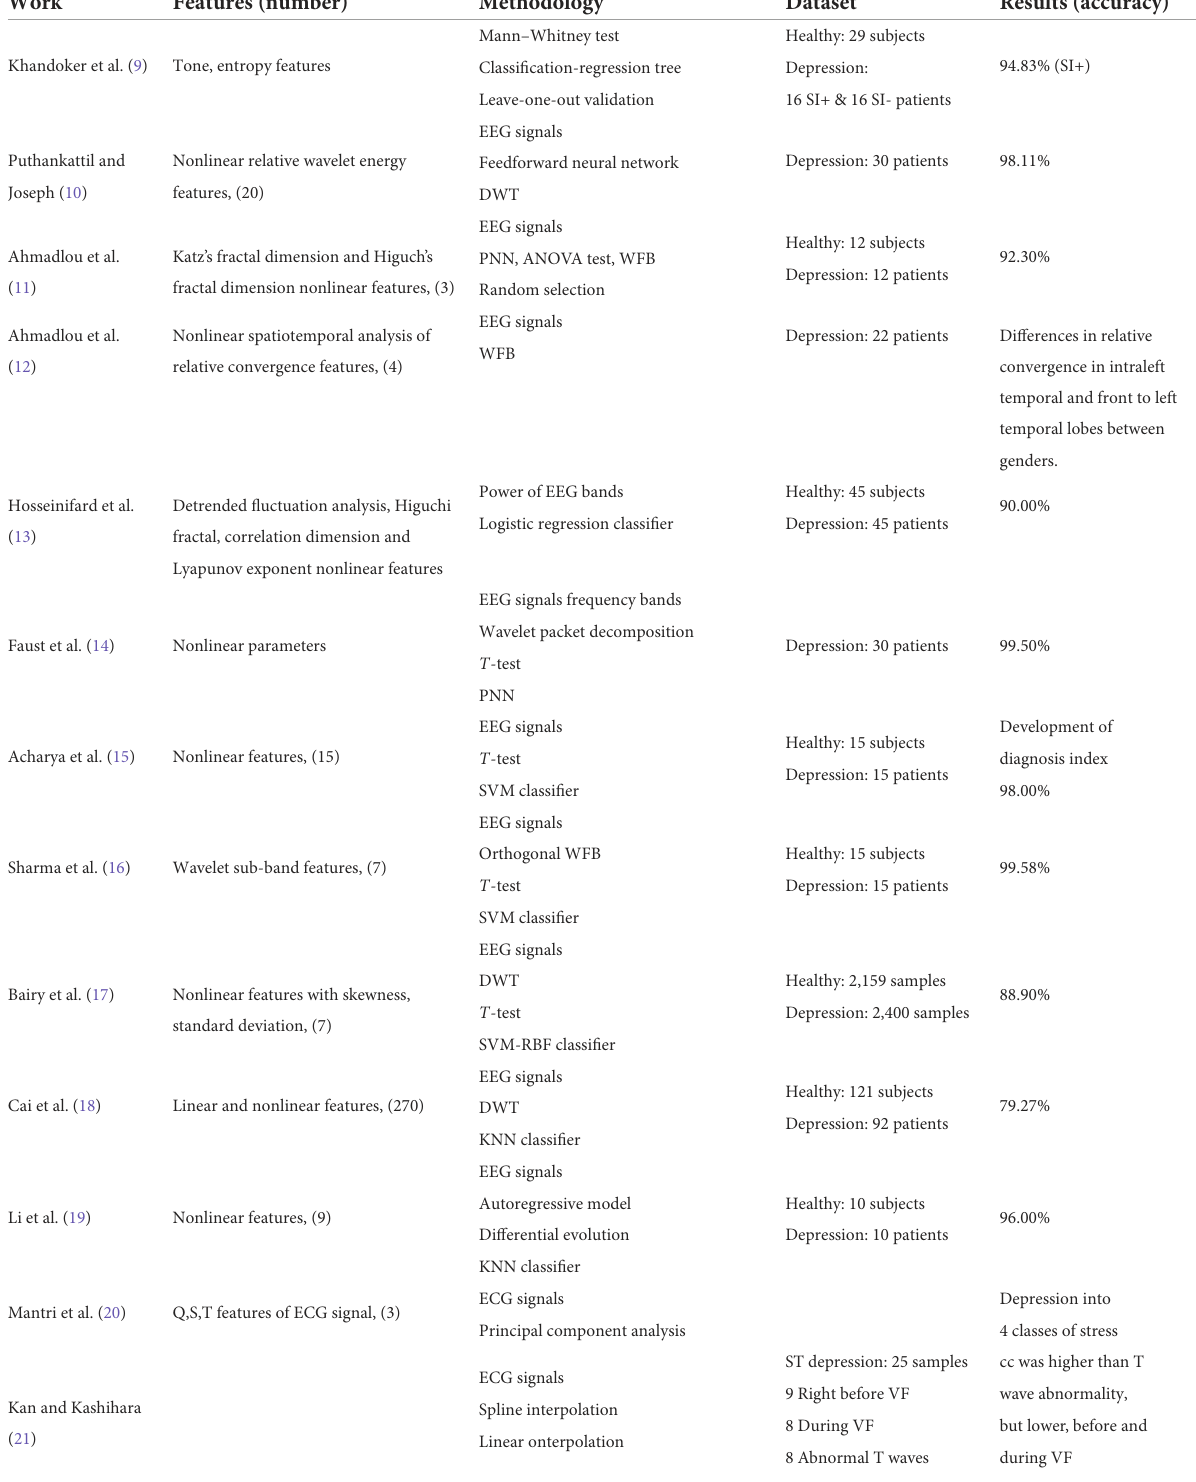
TABLE 1 Summary of literature works in automated detection and classification of